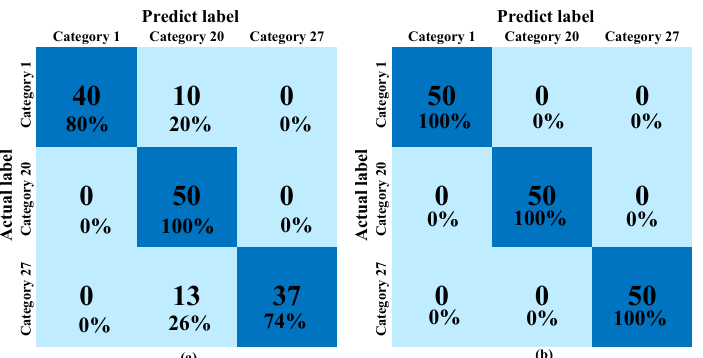
Figure 9. Confusion matrices obtained by FFT + PCA + SVM. ( a ) The results applied to traditional current control structure. ( b ) The results applied to the average current compensation mode.